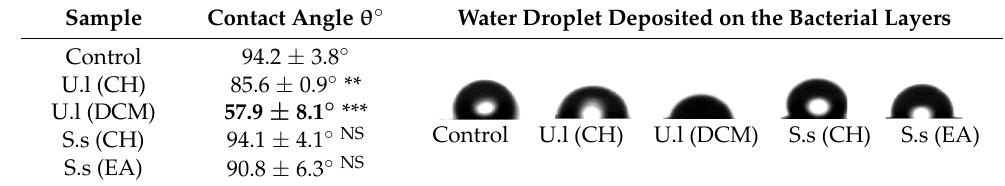
Table 2. Effect of the selected extracts (50.0 µg/mL) on S. aureus surface hydrophobicity assessed by measuring the contact angle ϴ °. Results are expressed as mean of ϴ ° determined at 5 random points per bacterial film ( ϴ ° ± SD). Statistically significant differences (***, p -value < 0.001, **, p -value < 0.01) between the extract treated bacterial layer and the untreated control one are indicated. NS : not significant.